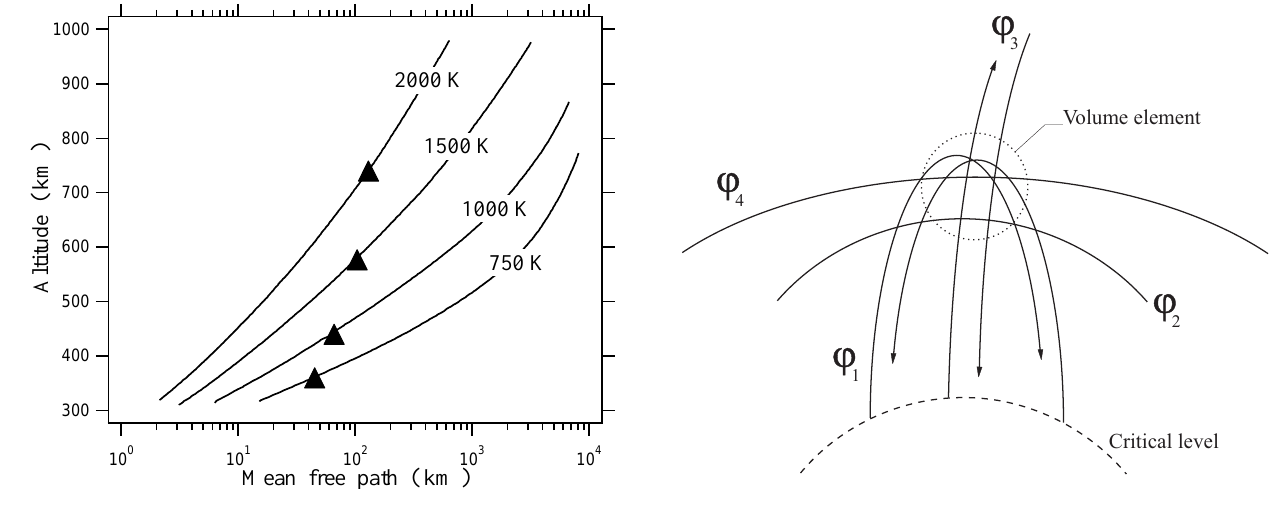
Fig. 13. Exospheric